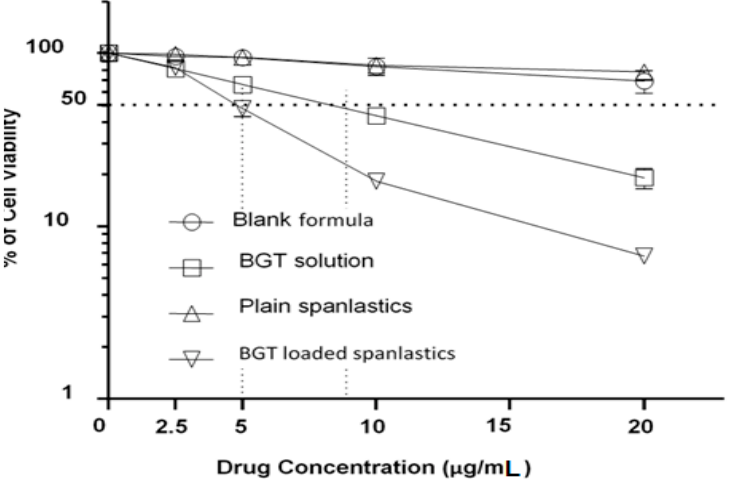
Figure 9. Cytotoxicity of BGT-loaded NSPs compared to plain NSPs, BGT solution, and blank formula on H-1975 NSCLC, as determined by a WST-1 assay. Cells were treated with varying concentrations of the drug as indicated for 48 h. Cell cytotoxicity was assessed using the WST1 assay and measured as % of survived cells relative to the non-treated control cells. Results obtained from three independent experiments. Error bars indicate means ± SD ( n = 3 ).